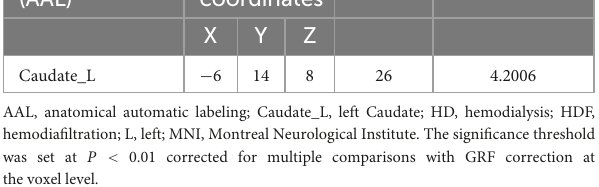
TABLE 3 Comparisons of CBF in different brain regions between HD + HDF ( n = 27) and HD ( n = 17). Brain regions